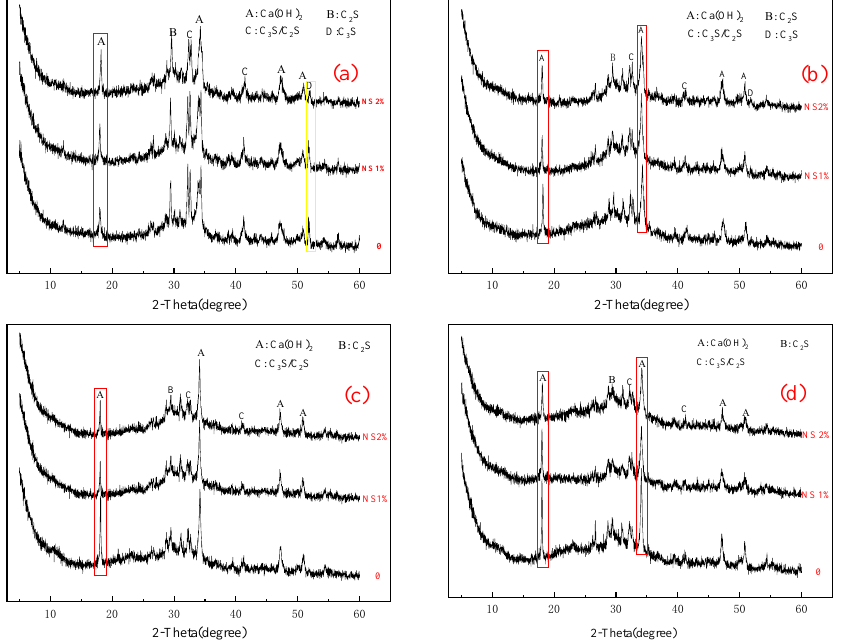
Figure 4. X-ray diffraction (XRD) patterns of the P · O 42.5 cement with different contents of nanosilica sol: ( a ) 1 day; ( b ) 3 days; ( c ) 7 days; ( d ) 28